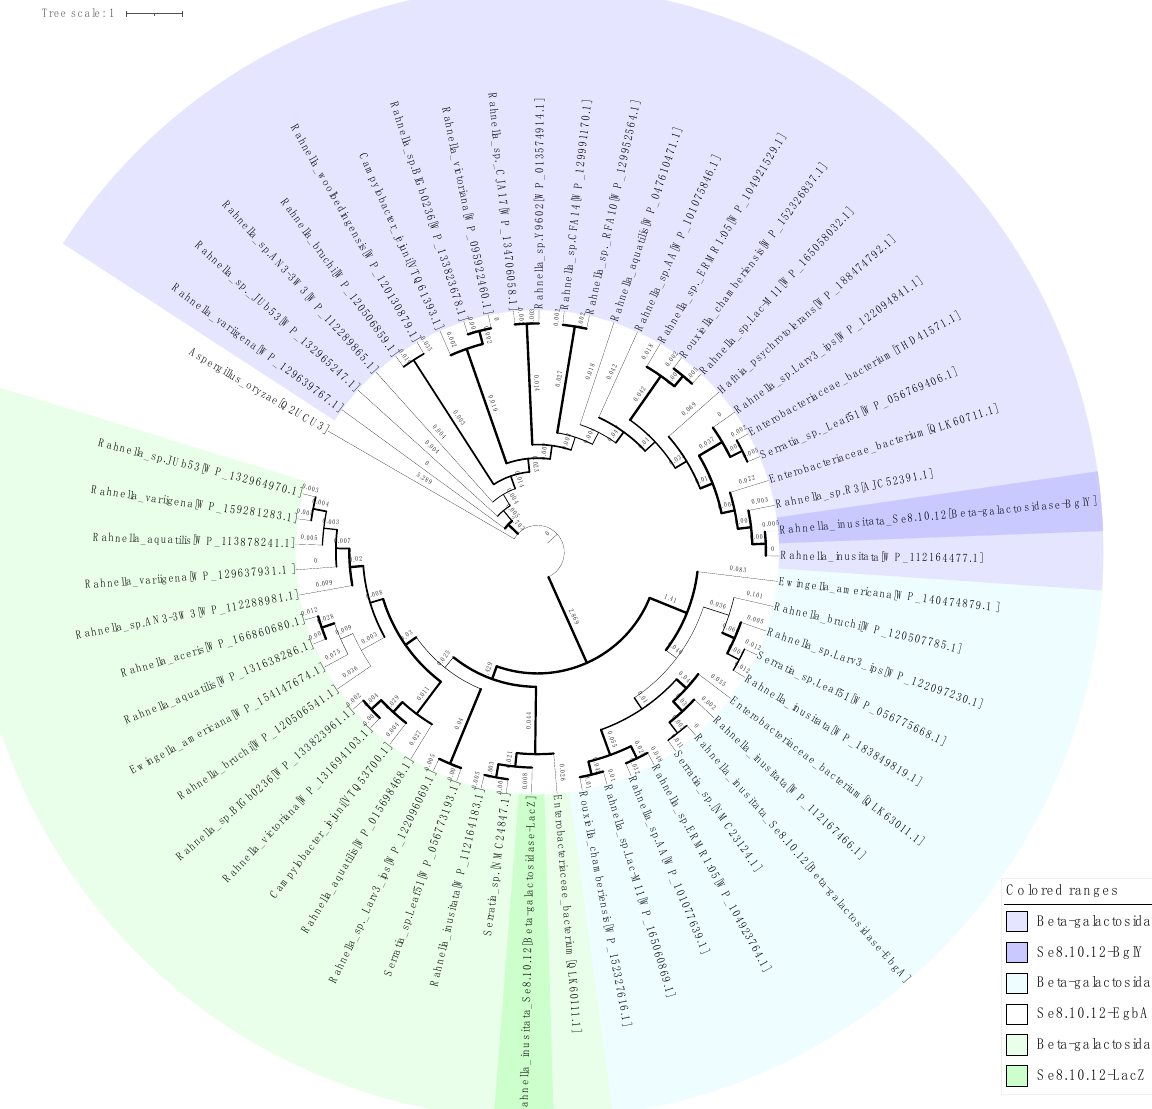
Figure 7. Maximum likelihood phylogram based on three β -galactosidase amino acid sequences of the strain Se8.10.12 (highlighted color) and proteins on nucleotide database with >85% similarity (light color). Aspergillus oryzae β -galactosidase LacA was used as an outgroup. Branch lengths are shown in each branch and represent the number of nucleotide substitutions per site. Bootstrap support based on 1000 replicates ultrafast method is represented as branch width (1 px line = 47% to 10 px line = 100%). GenBank/EMBL/DDBJ accession numbers are provided in brackets.